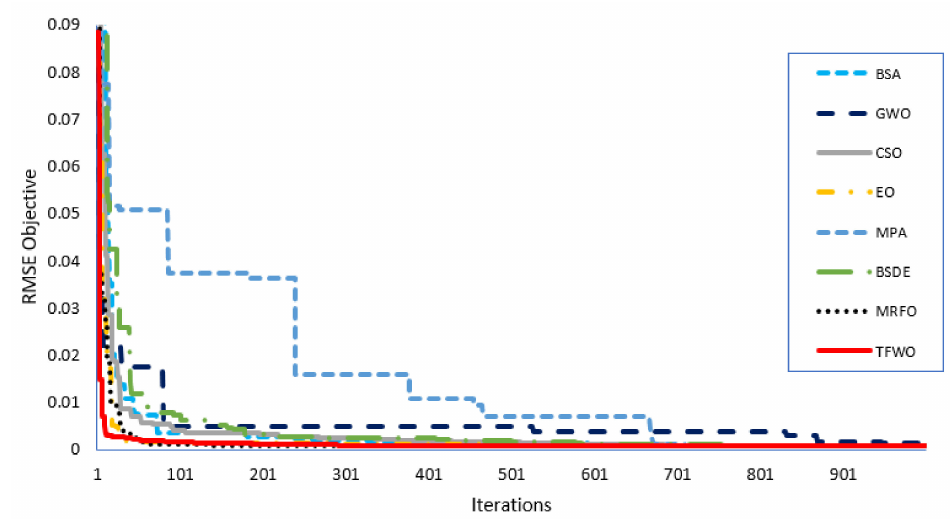
Figure 13. The convergence curves for R.T.C. France TDM.